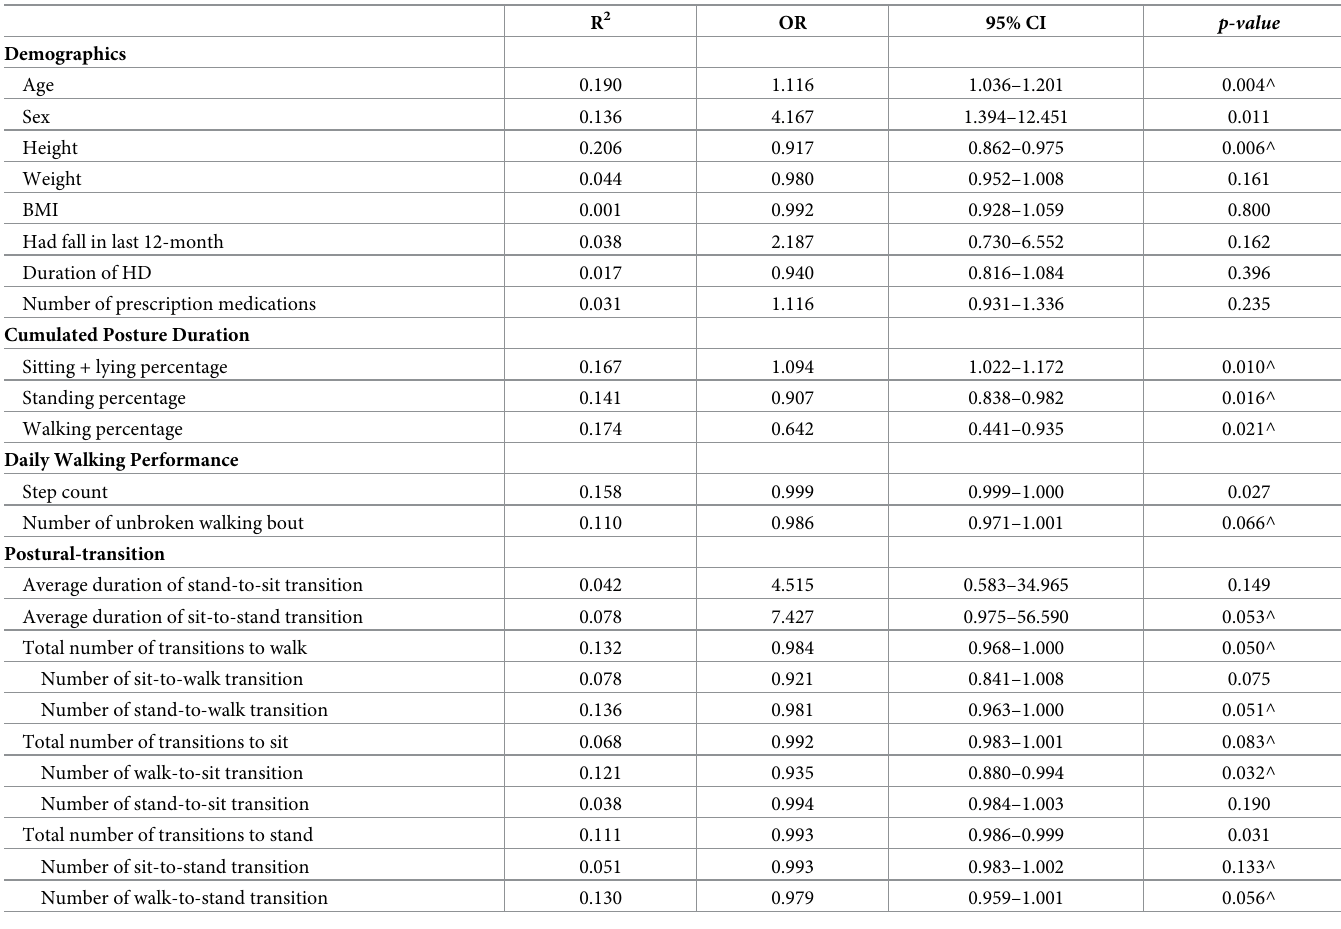
Table 3. Results of univariate and multivariate logistic regression.